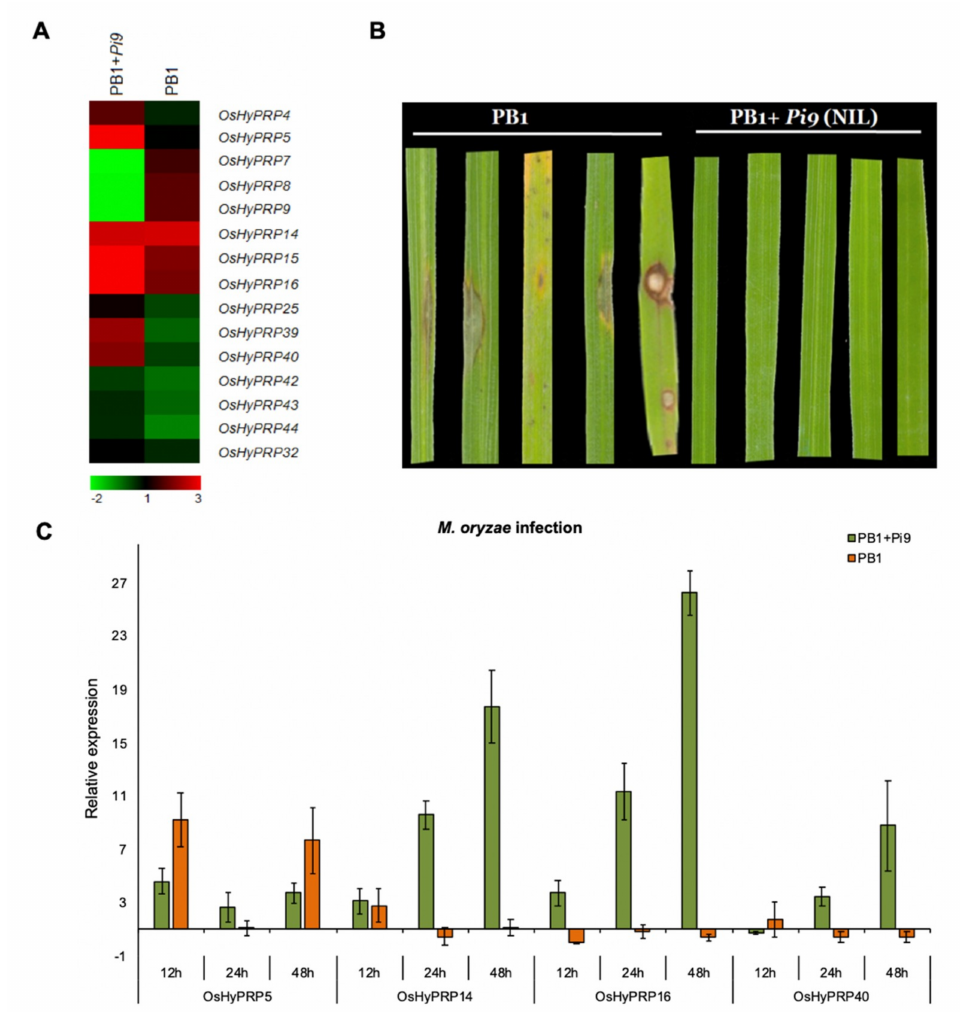
Figure 4. The expression of OsHyPPR genes in response to M. oryzae . ( A ) The heat map for the expression profile of OsHyPRP genes as determined through RNA-Seq analysis of PB1 and PB1 + Pi9 in response to M. oryzae after 24 hpi. The expression shown here is the log2 fold change value as compared to mock-treated PB1 and PB1 + Pi9 . ( B ) The picture is showing disease lesions in PB1 after seven days of M. oryzae inoculation, while no disease lesions were present in PB1 + Pi9 ( C ) The qRT-PCR based expression profile of four OsHyPRP genes showed up-regulated expression in RNA-Seq analysis. The calculated expression level was relative to the untreated respective rice lines. The experiment was performed with three technical replicates of three independent biological replicates. The error bars represent the standard error of the means of three independent biological replicates. The rice elongation factor-1A ( OsEF-1a ) gene was used to normalize the qRT-PCR expression